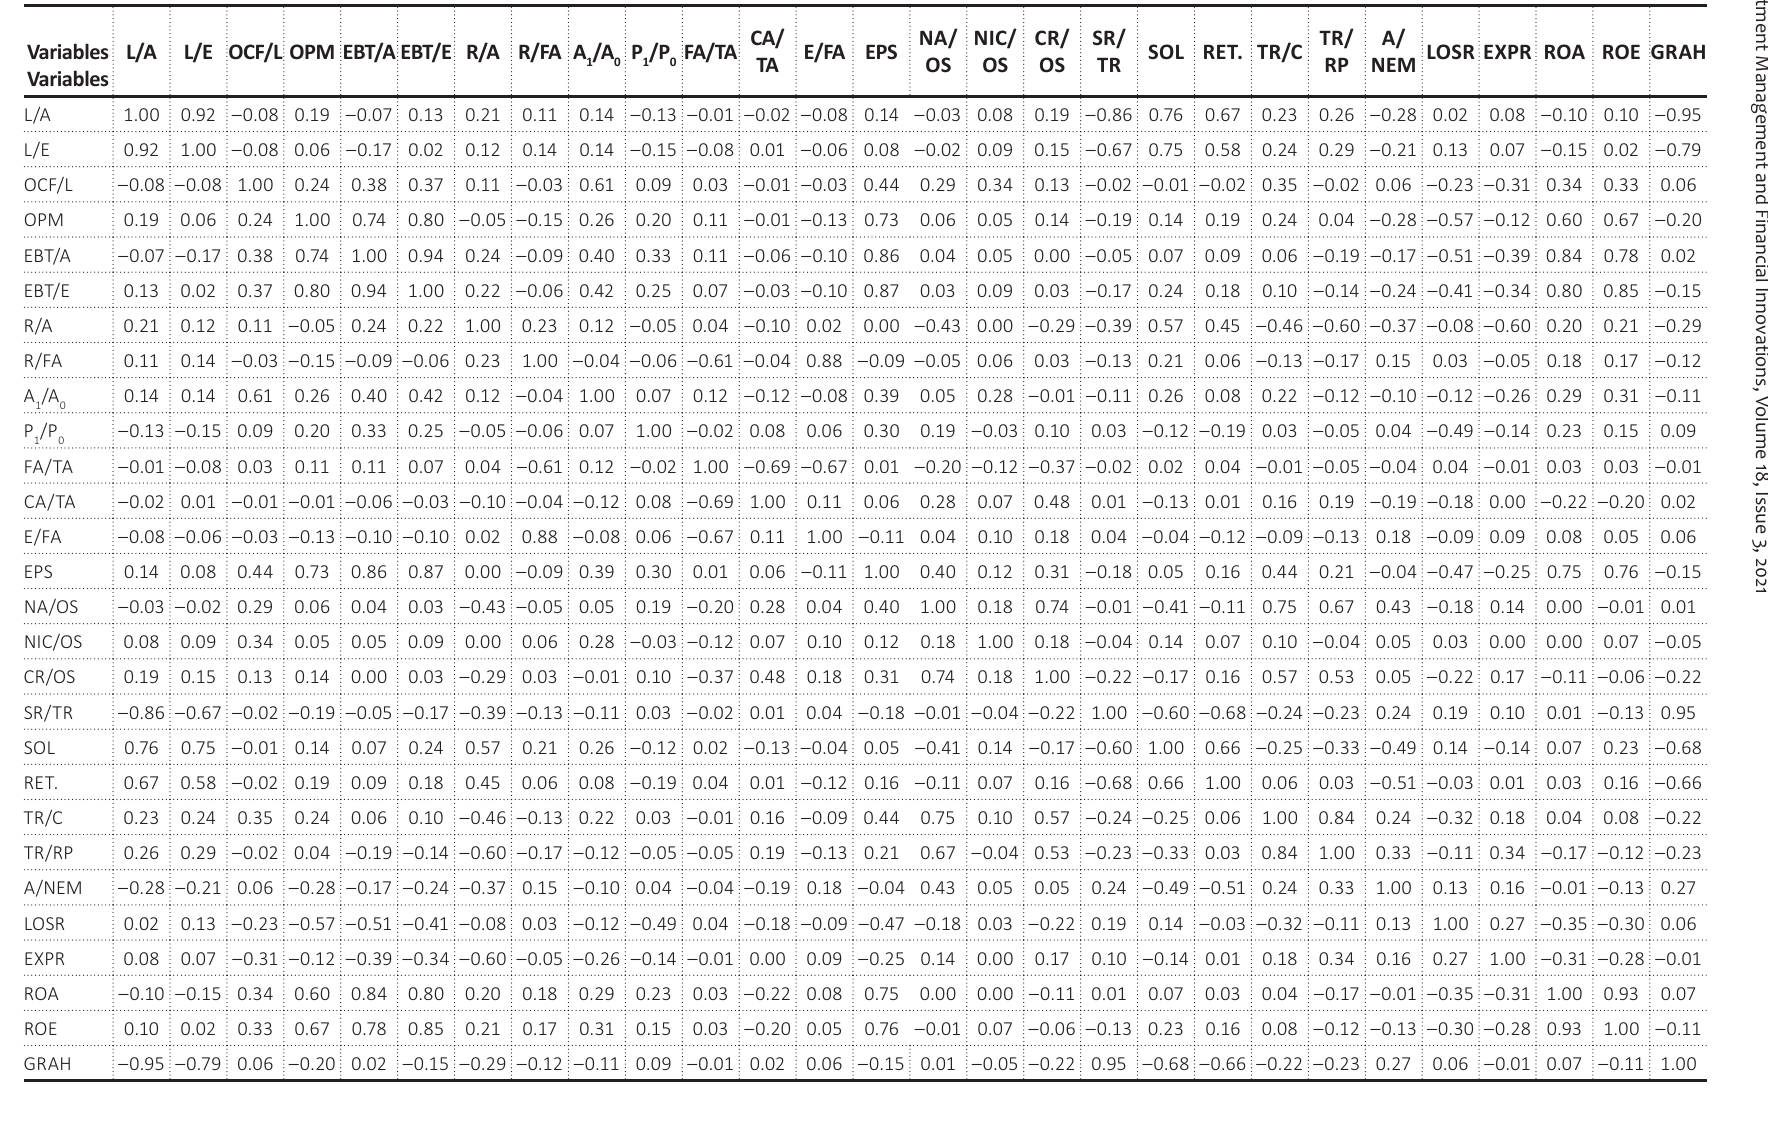
Table 3. Correlation pooled within group